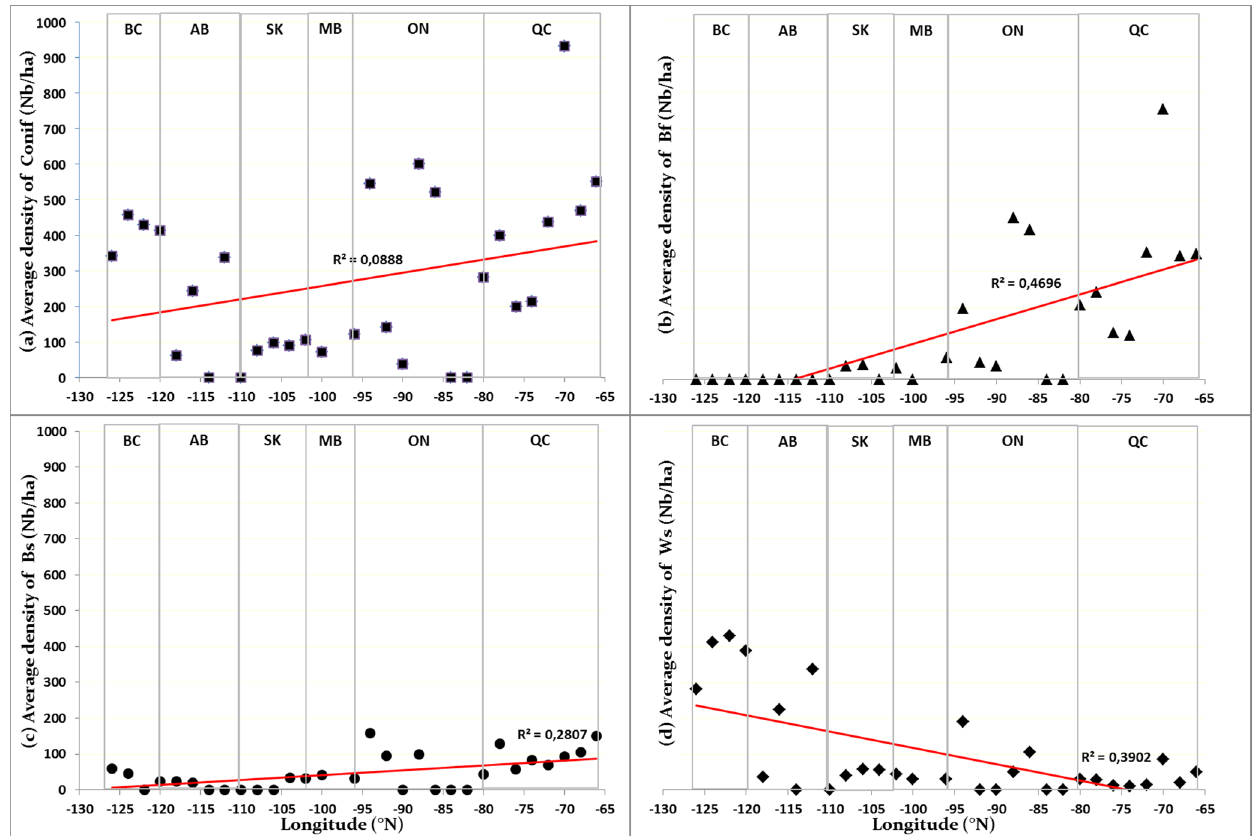
Figure 2. Density distribution of coniferous regeneration (Conif), along the east-west gradient in Canada. Bf, balsam fir; Bs, black spruce; Ws, white